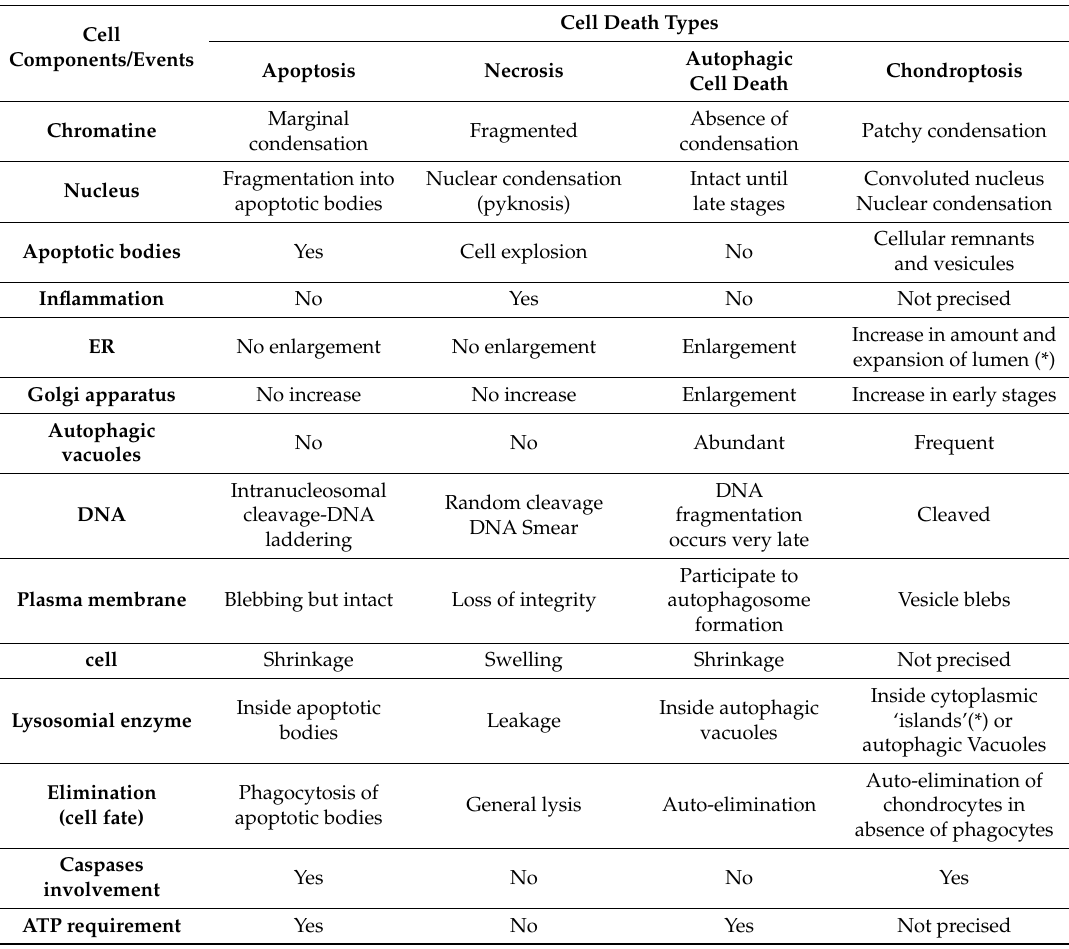
Table 1. Cell death features. The (*) indicate the exact terms used by Roach et al.